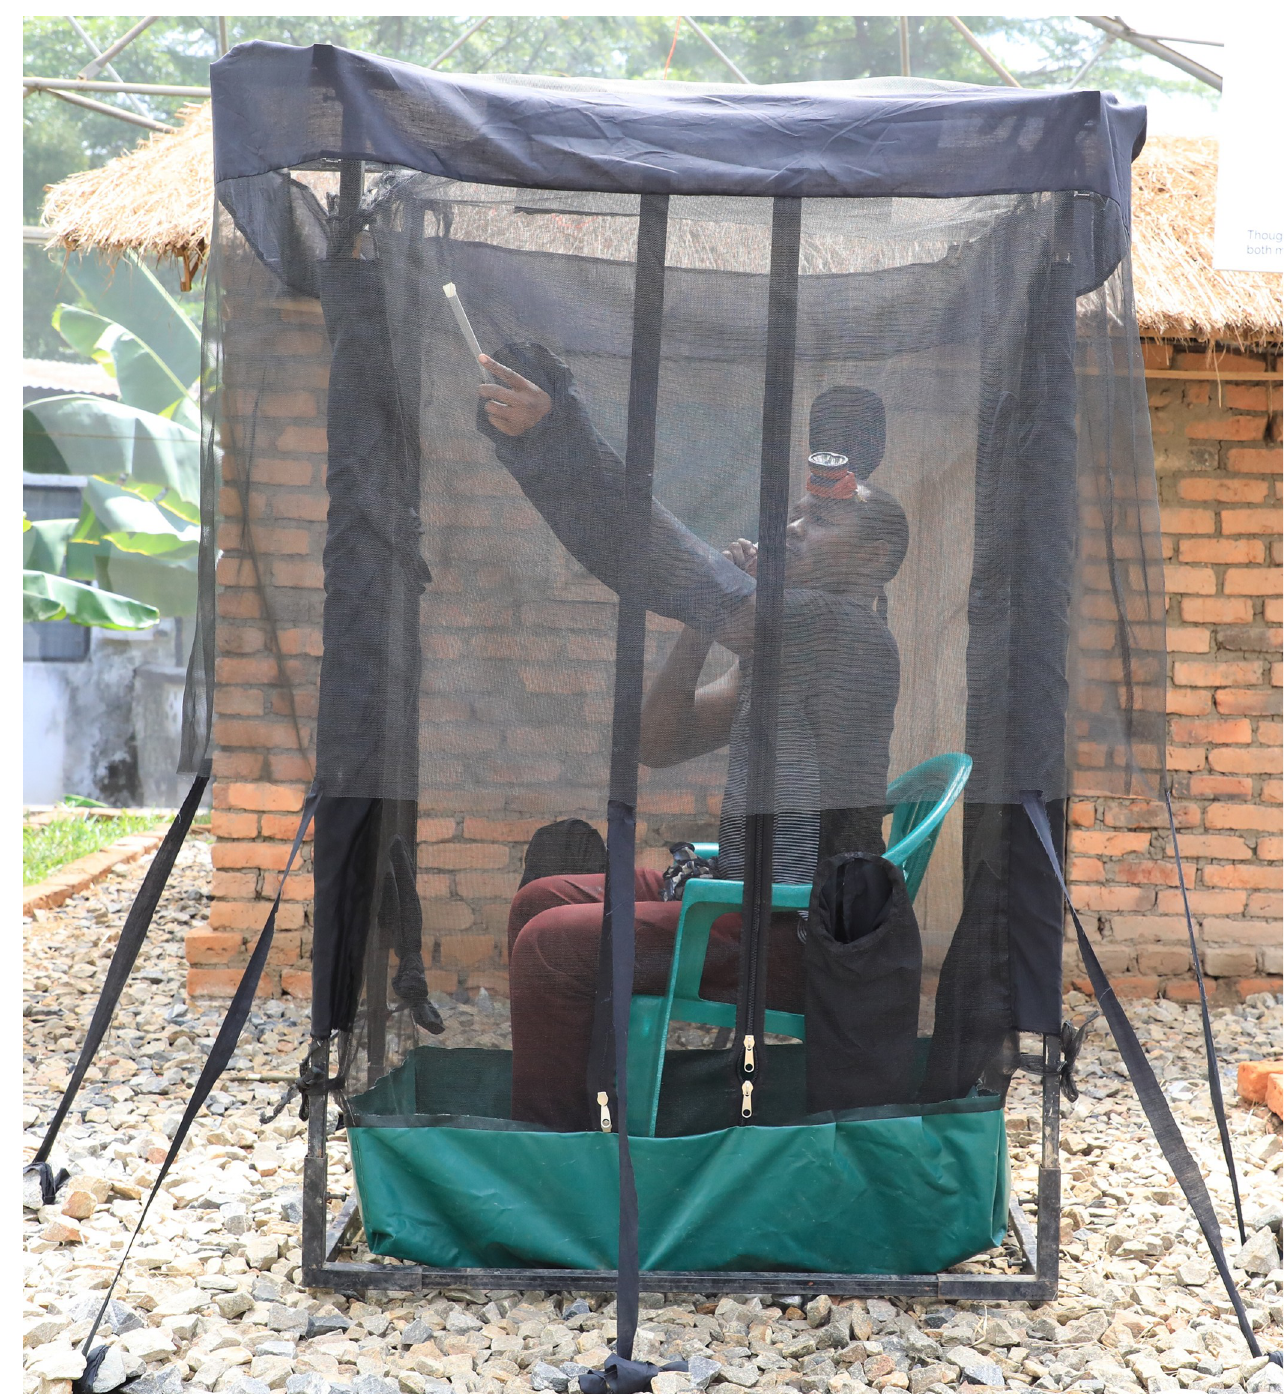
Fig 3. Miniaturized double-net trap (DN-Mini) for comparison of indoor and outdoor mosquito densities. length and 180cm height, and has an outer overhang netting (100cm-height) to allow entry of mosquitoes between the layers, while preventing escape. The inner netting has multiple sleeves through which a volunteer can retrieve the trapped mosquitoes. Two DN-Mini traps were